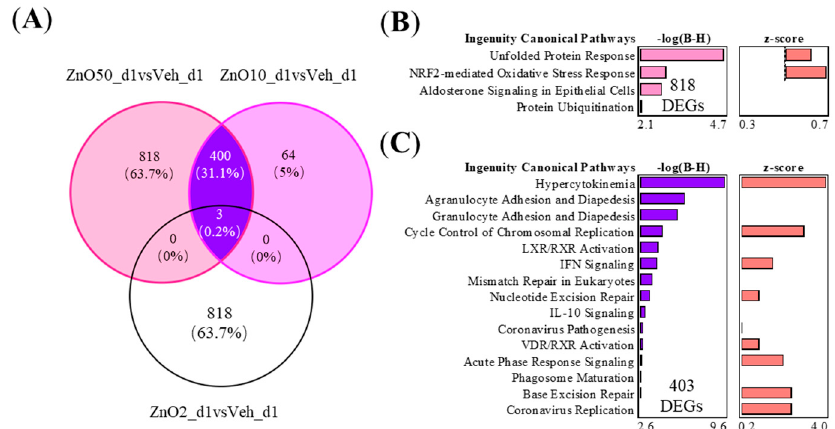
Figure 3. The nZnO-treated mouse lung tissues have specific or shared gene expressions with varying functions depending on the particle concentration 1 day after the exposure. ( A ) The exposure to nZnO yielded 403 shared and 818 or 64 specific DEGs in the VENN diagram for nZnO 50 μ g or nZnO 10 μ g, respectively. The different canonical pathways (IPA) are shown in ( B ) for 818 DEGs, which are exclusively expressed after exposure to 50 μ g of nZnO, and in ( C ) for 403 DEGs after exposure to 10 or 50 μ g of nZnO. The negative logarithm of the p -value calculated by the right-tailed Benjamini-Hochberg test is equal to increased significance. The predicted pathway activation (red bars) or inhibition are represented in the z-score bar chart.